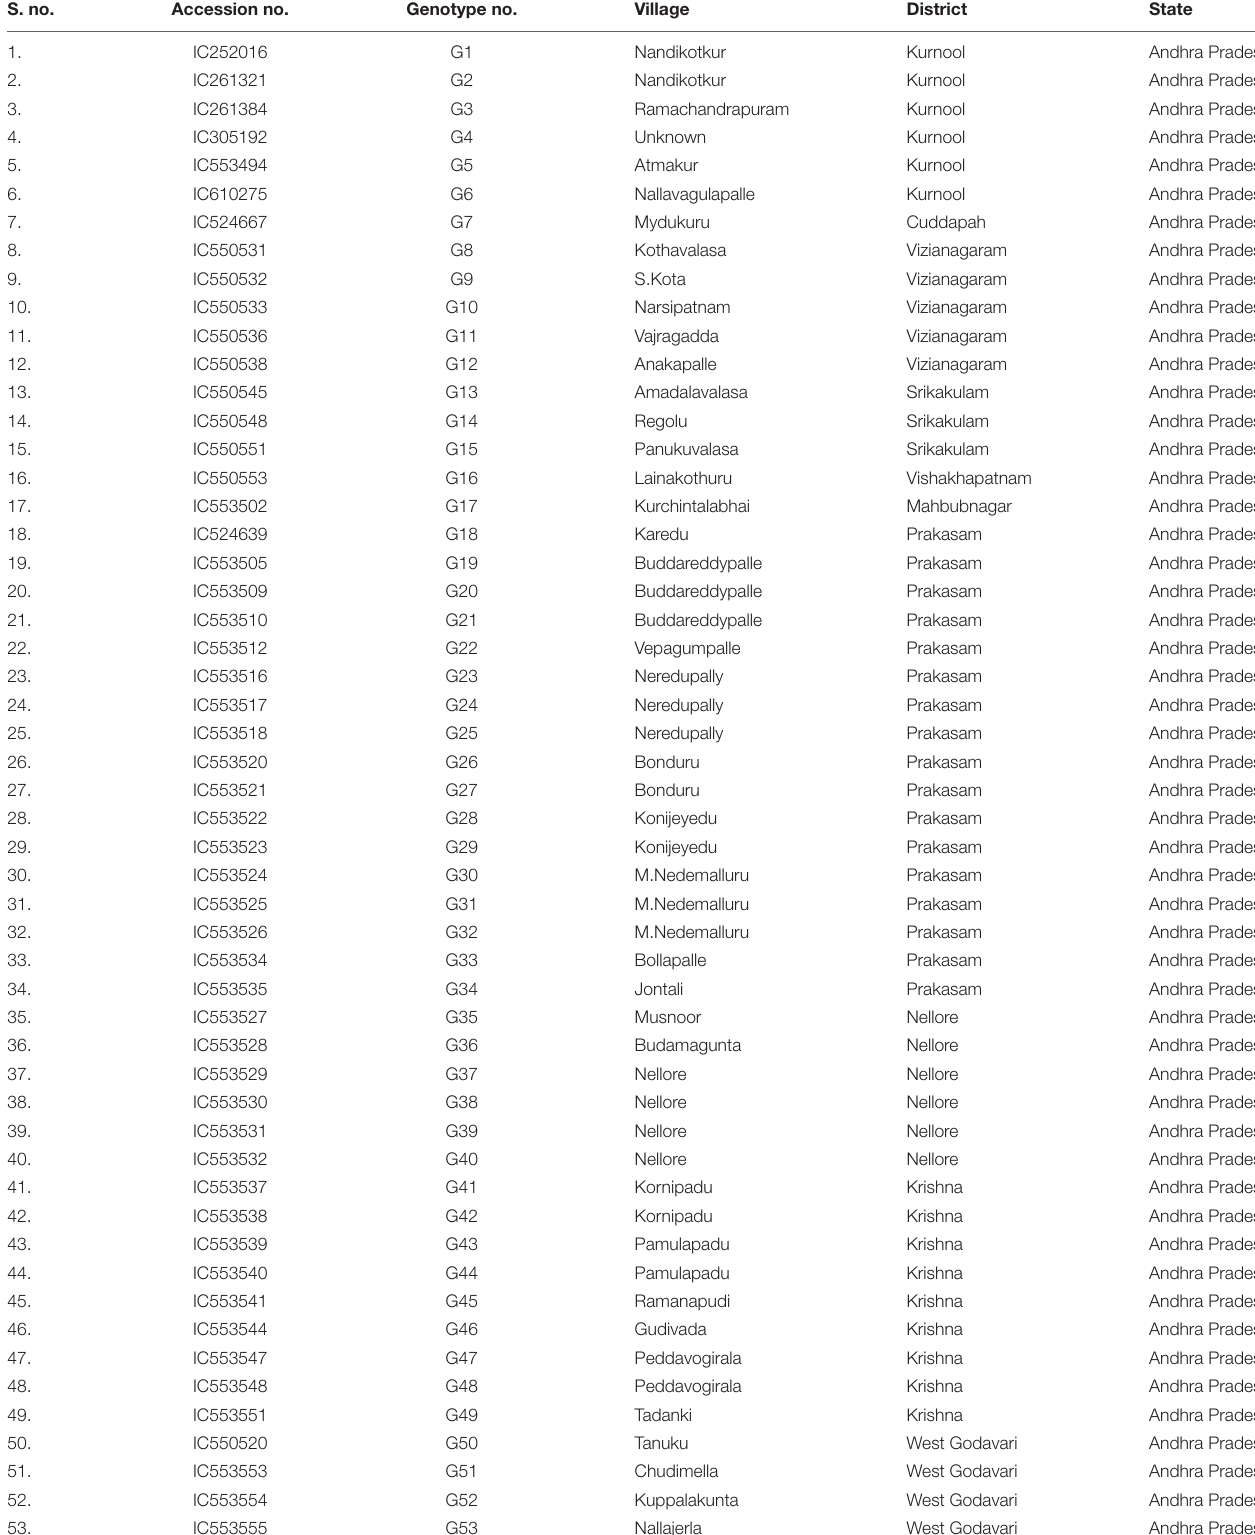
TABLE 1 | Details of accessions and their geographical